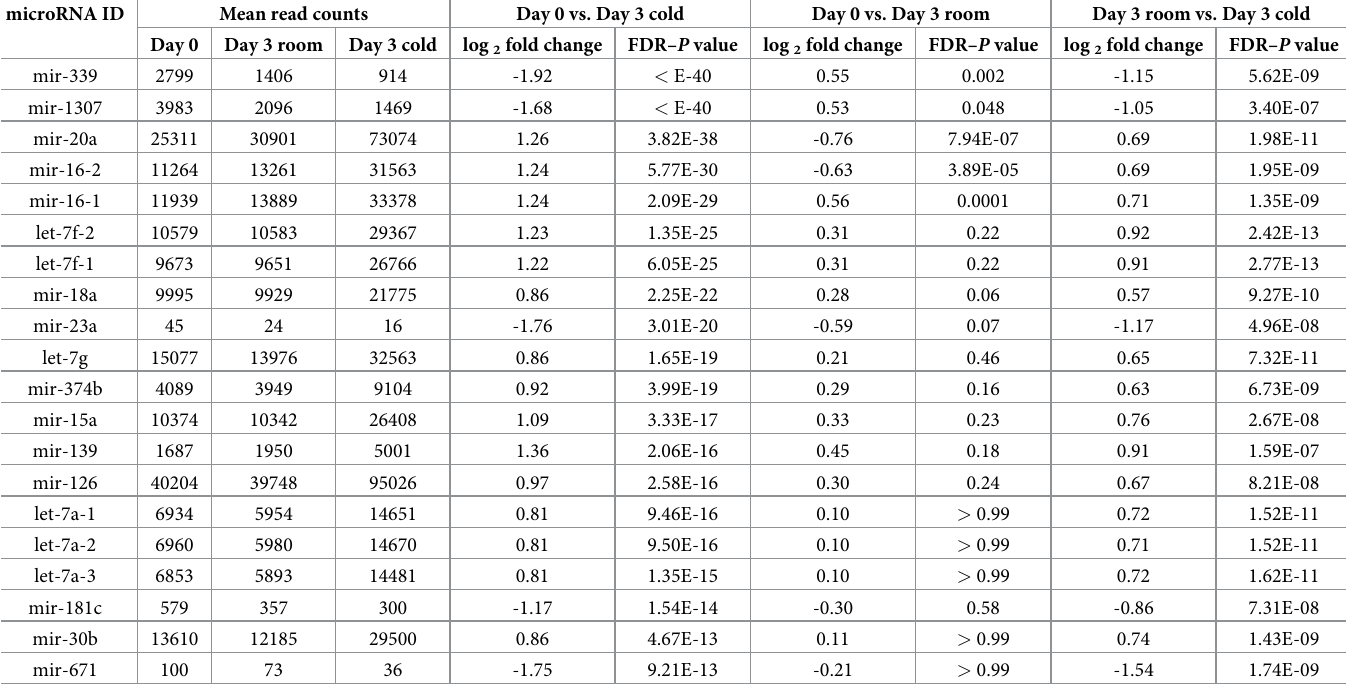
Table 1. Differentially expressed miRNAs under three different